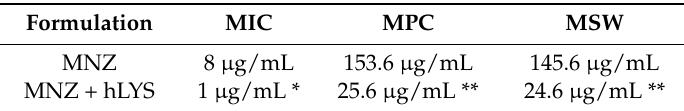
Table 2. Effect of hLYS (0.3 mg/mL) on the MIC, MPC and MSW of MNZ to H. pylori